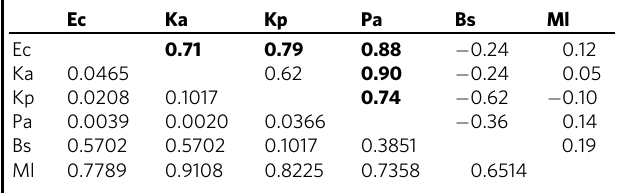
Table 1 Spearman ’ s rank correlation of average performance of natural strains across different